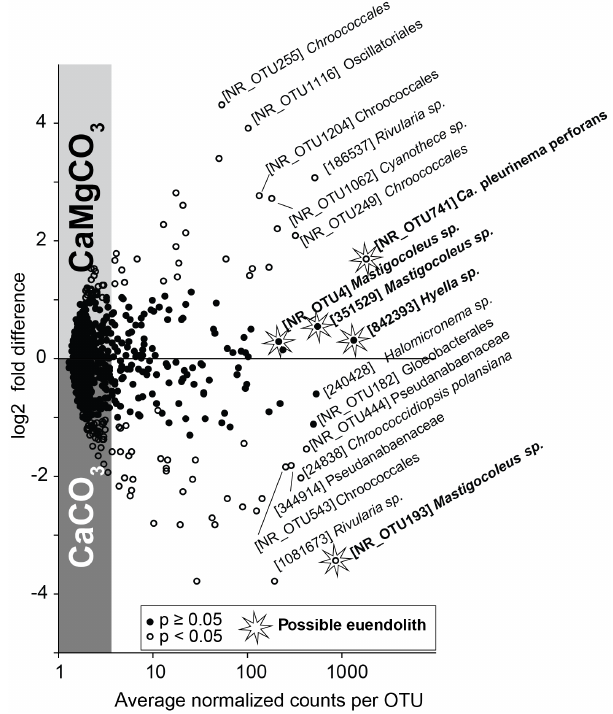
Figure 4. Differential abundance of cyanobacterial OTUs in Ca car- bonates (calcite–aragonite) n = 14 vs. CaMg carbonate (dolomite) n = 13 samples. This plot was constructed using the DESeq2 method. It displays the average normalized counts per OTU as a measure of abundance against the log2 fold difference. The OTUs that were significantly differentially abundant in the two conditions ( p <0.05) are represented as open circles; the other ones are dis- played as close symbols. Positive values indicate enrichment to- wards CaMg carbonate and negative values indicate enrichment to- wards Ca Carbonate. The OTU ID and taxonomical assignment of the most abundant OTUs is displayed on the right. The stars tag the possible euendolithic OTUs as determined by phylogenetic proxim- ity to known microborers (Fig.